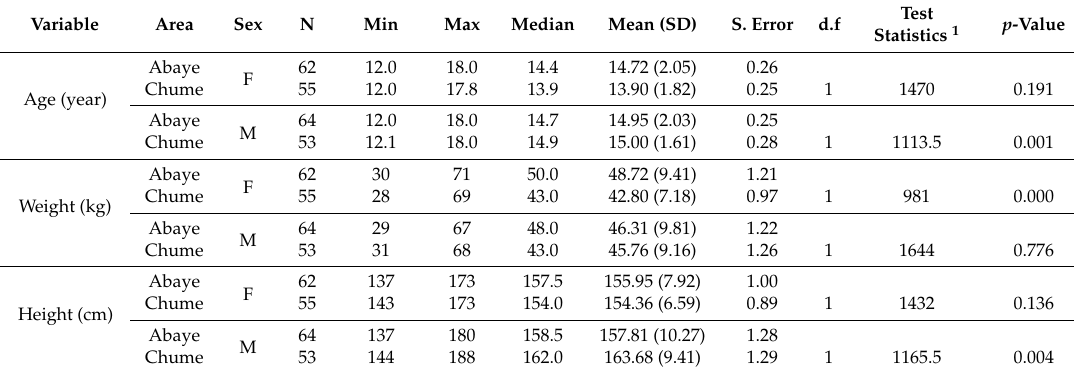
Table 1. Socio-demographic characteristics of the sample adolescents from the Sidama Zone, Southern